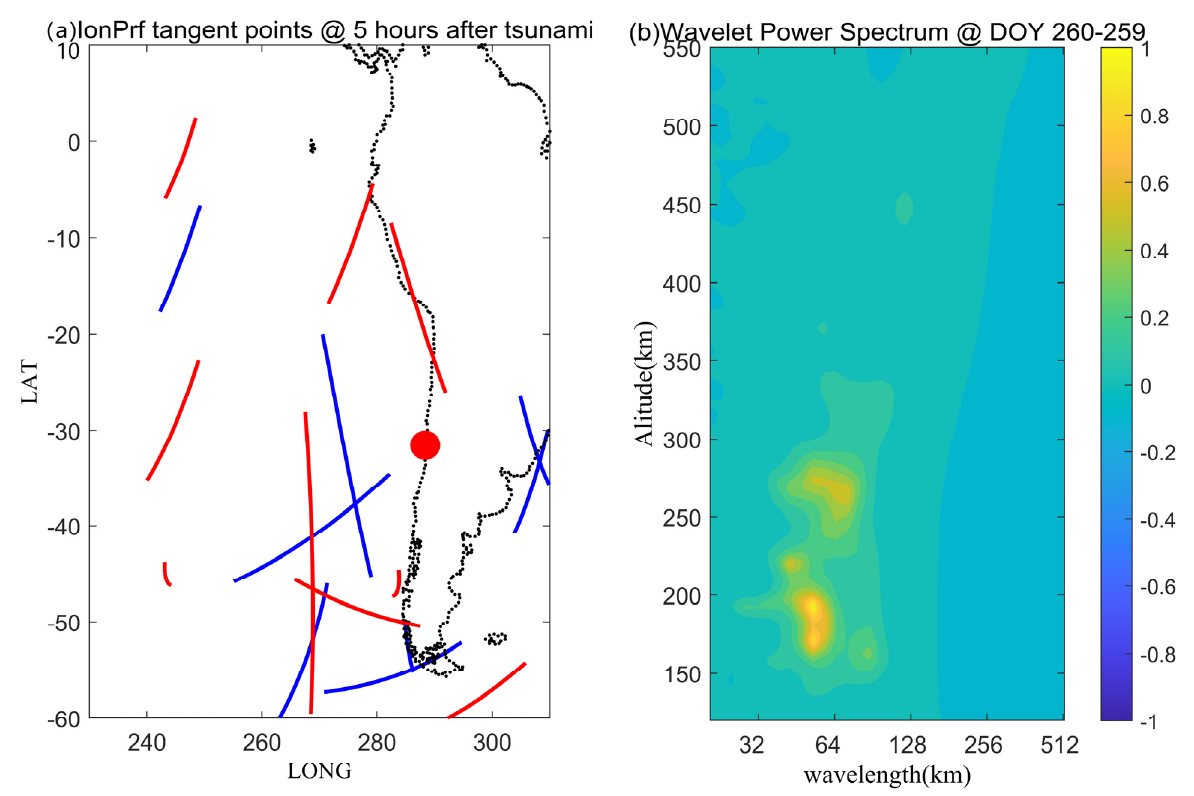
Figure 10. ( a ) The projections of the tangent points 5 h after the tsunami for the F3/C ionPrf dataset. Blue and red lines mark the ground track of the tangent point location on DOY 259 and 260 of 2015, respectively. The thick red point shows the epicenter. ( b ) The corresponding wavelet power spectrum differences between DOY 259 and 260 of 2015.